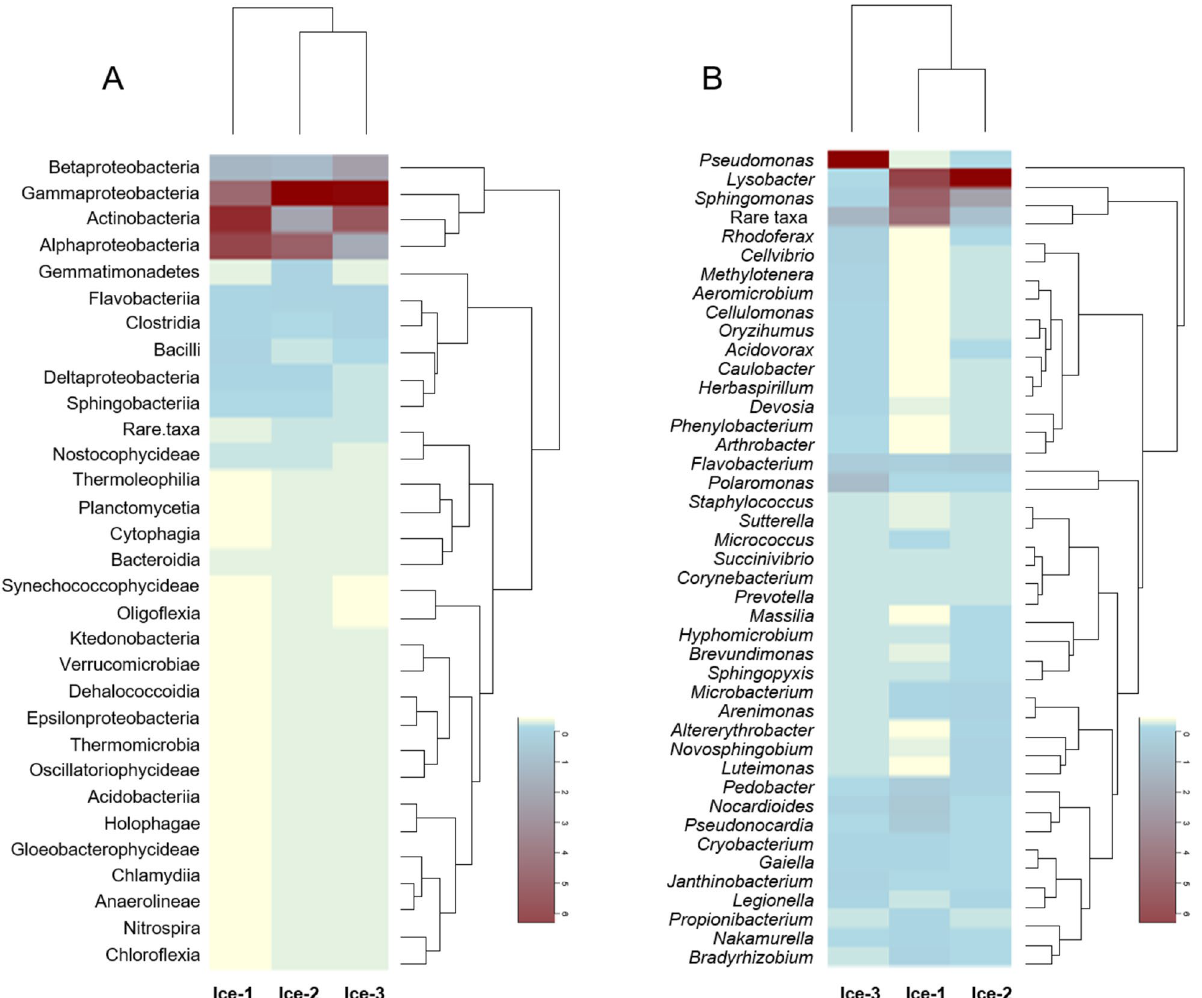
Figure 3. Heat-map analysis of the relative abundance of members of cave-ice prokaryotic communities at class ( A ) and genus ( B ) levels in Ice-1, Ice-2 and Ice-3. Phylotypes whose relative abundances at class level were < 0.1% and phylotypes whose relative abundances at genus level were < 0.05% were amalgamated and classified as “Rare